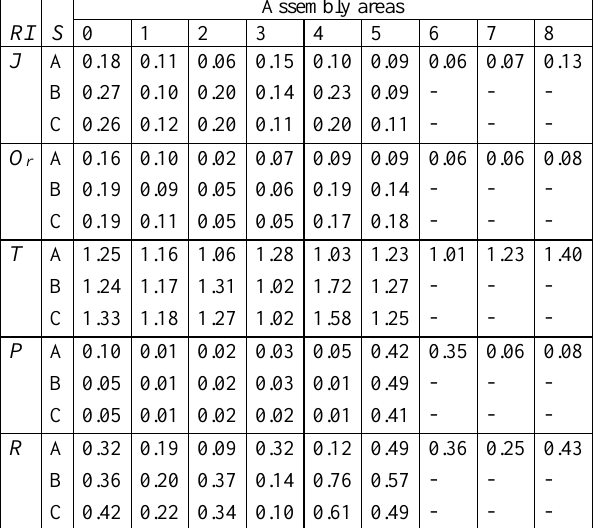
Table 2. Comparison of risk indexes RI for the considered assembly areas, in each of the considered scenarios S . For the assembly areas codes, refer to Figure 2 for SCENARIO A and to Figure 5 for SCENARIO B and SCENARIO